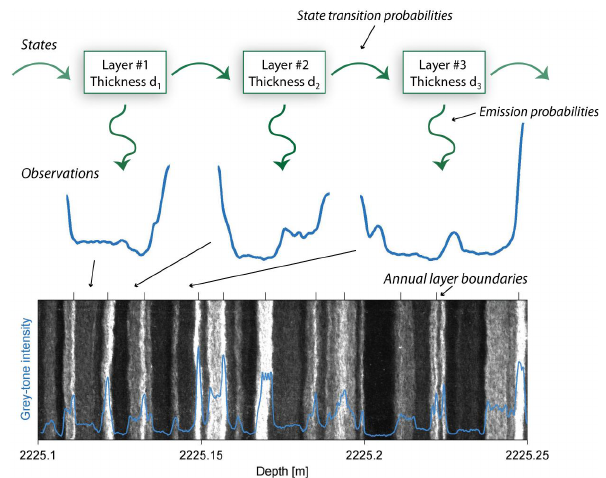
Fig. 1: Illustration of the two-level structure of the Hidden Semi-Markov Model used for annual layer detection. The states of the system are “layer numbers”, which have been endowed with a layer thickness parameter d . Changes in state are described by state transition probabilities. Each state emits a segment of observations corresponding to one layer. In this case, the observations are grey-tone intensity values based on line-scan images from the NGRIP ice core (bottom). Based on the entire sequence of observations, the HMM algorithm can be used to infer the most likely state sequence (i.e. the depth-age relationship) along with its corresponding uncertainty.